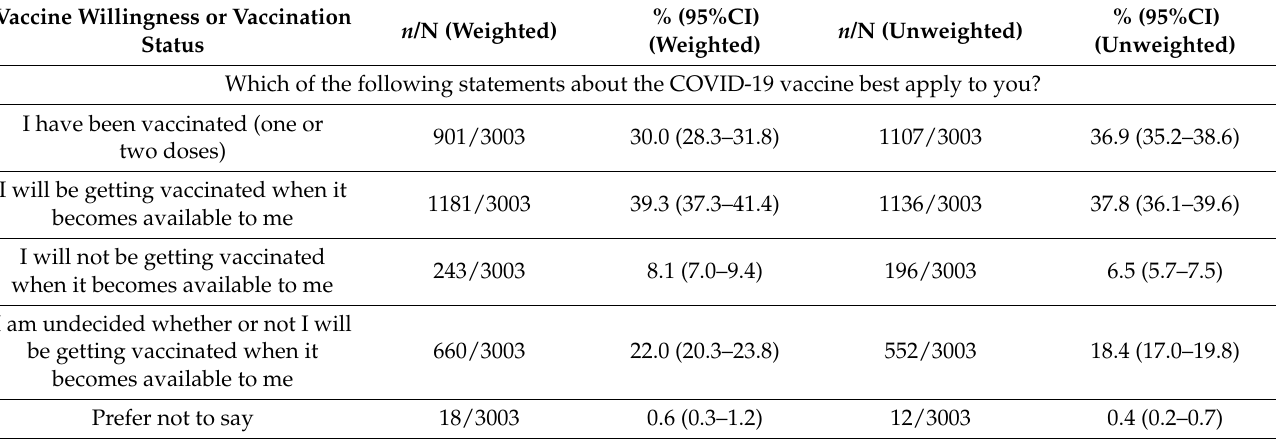
Table 2. Descriptive statistics of self-reported vaccination status and vaccine willingness to get vaccinated for themselves or their children.